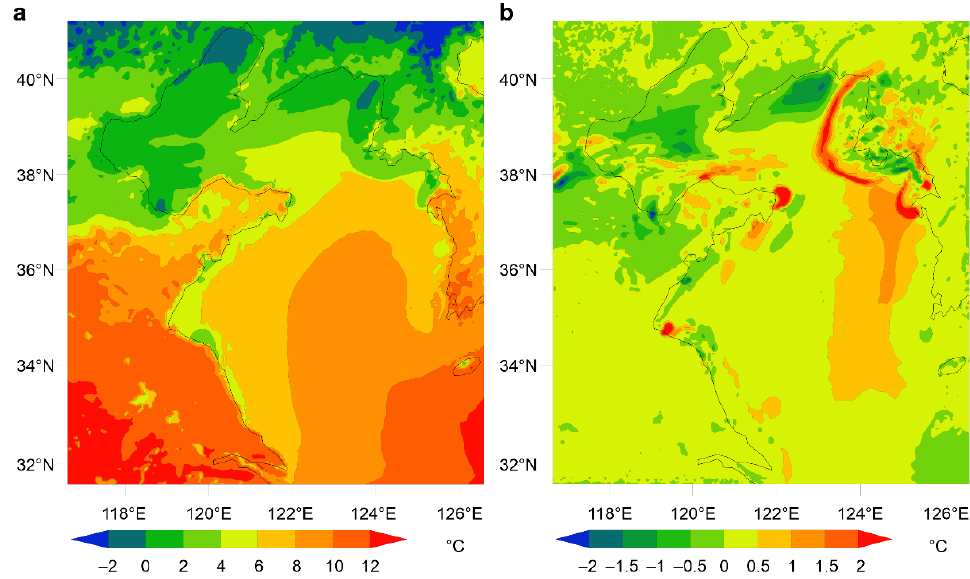
Figure 9. ( a ) CODAS simulated 2-m temperature and ( b ) its difference with respect to the FNL simulated 2-m temperature at 00:00 on 20 February 2020 for 48-h forecasting.